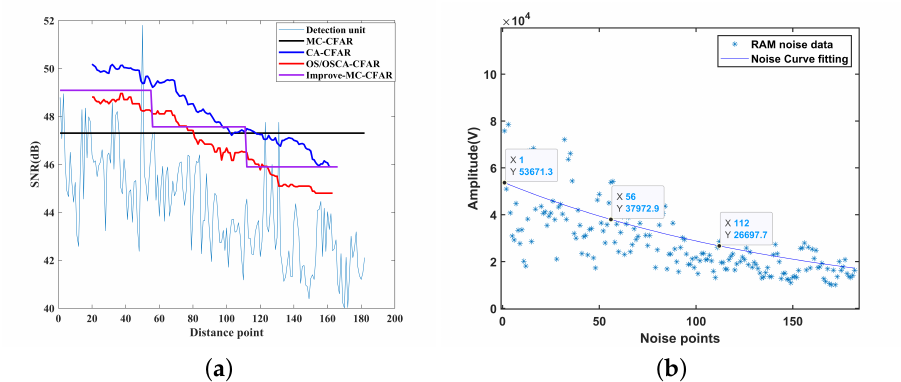
Figure 17. The improved MC-CFAR algorithm performance. ( a ) Target detection under non-uniform noise. ( b ) Noise region division based on the fitting